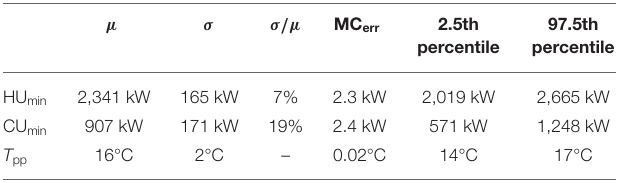
TABLE 4 | Uncertainty analysis results for the minimum possible input uncertainty on k = 205 parameters.